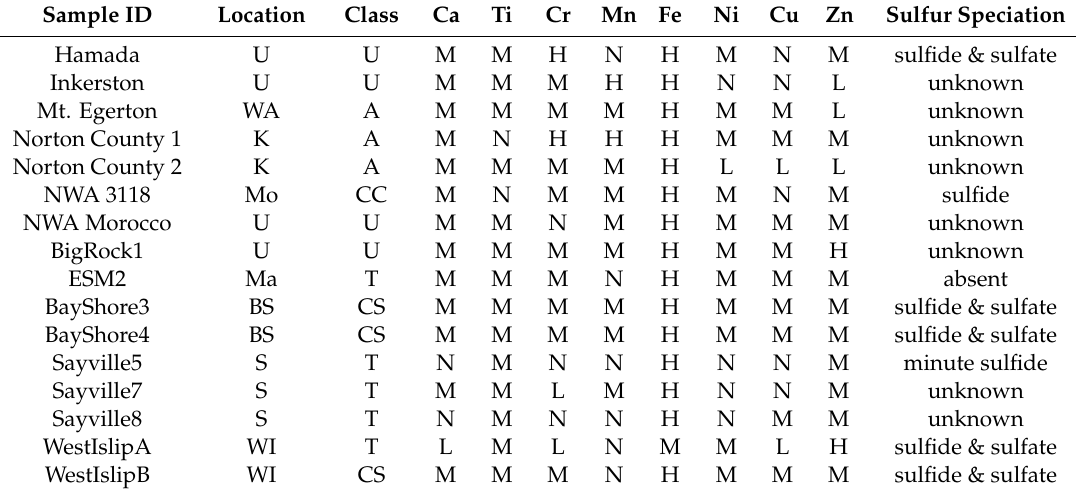
Table 1. Metals detected using SRX and sulfur speciation determined with XANES using